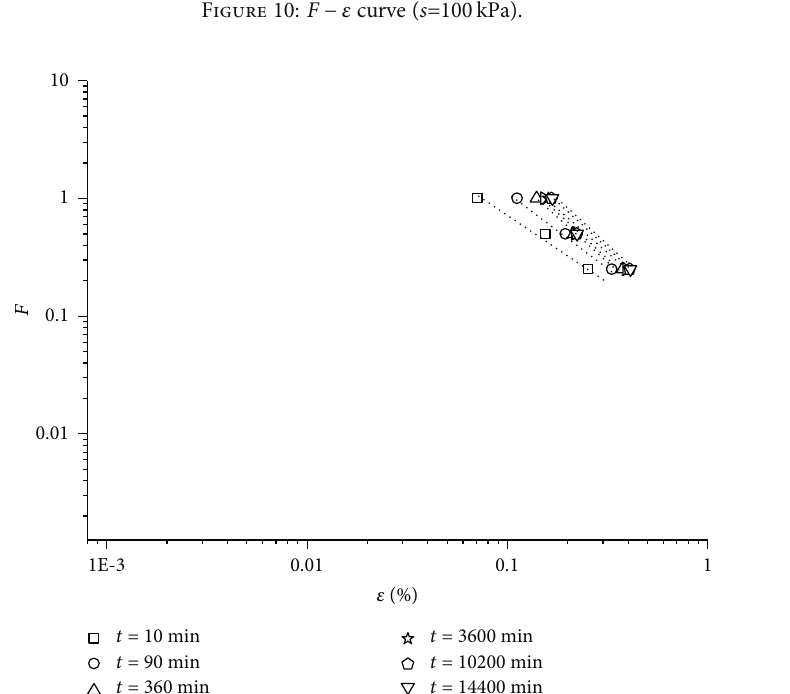
Figure 10: F − ε curve ( s